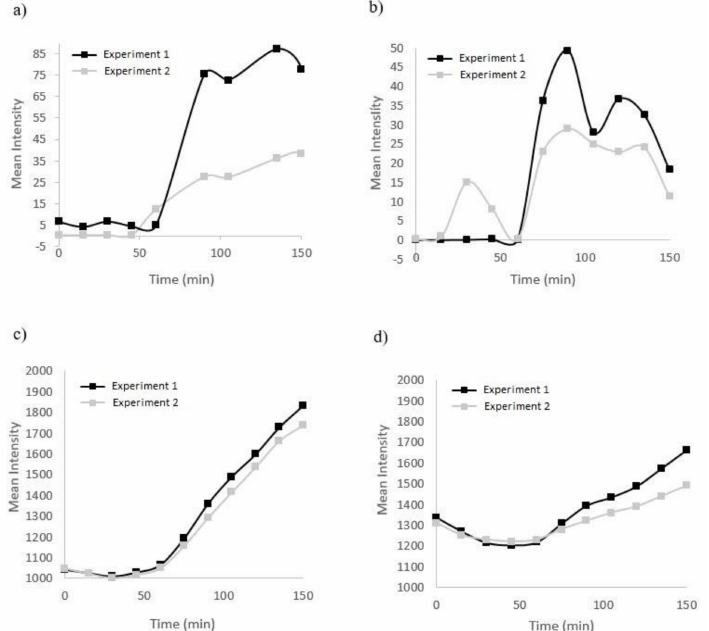
Figure 5. Fluorescence signal from hypoxia and nitric oxide in the cells. ( a ) Hypoxia in one channel; ( b ) hypoxia in two channels; ( c ) nitric oxide in one channel; ( d ) nitric oxide in two channels. The black and grey datasets are two independent